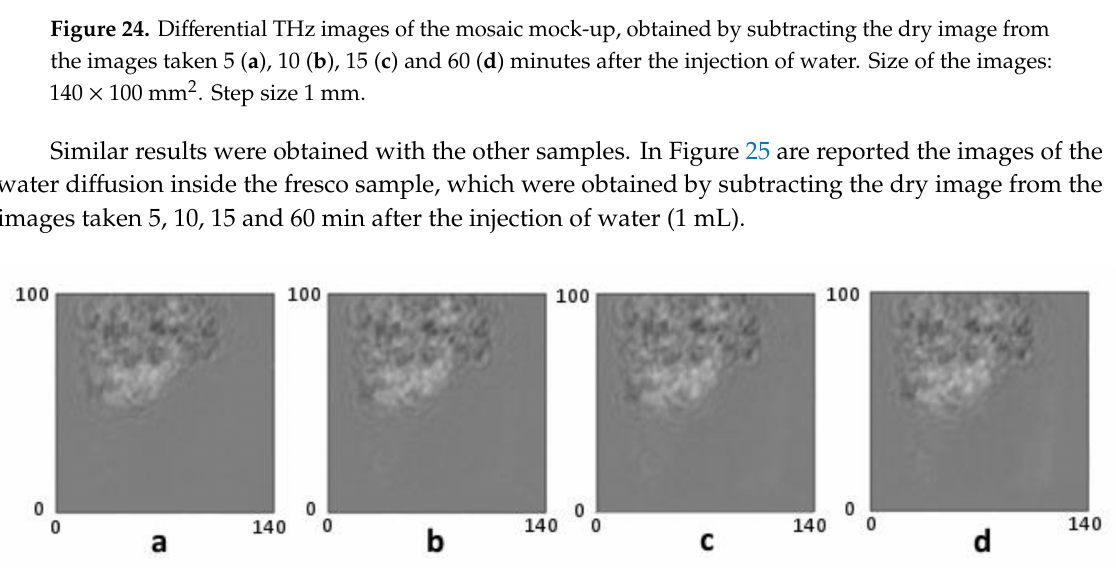
Figure 25. Di ff erential THz images of the fresco sample, obtained by subtracting the dry image from the images taken 5 ( a ), 10 ( b ), 15 ( c ) and 60 ( d ) minutes after the injection of water. Size of the images: 140 × 100 mm 2 . Step size 1